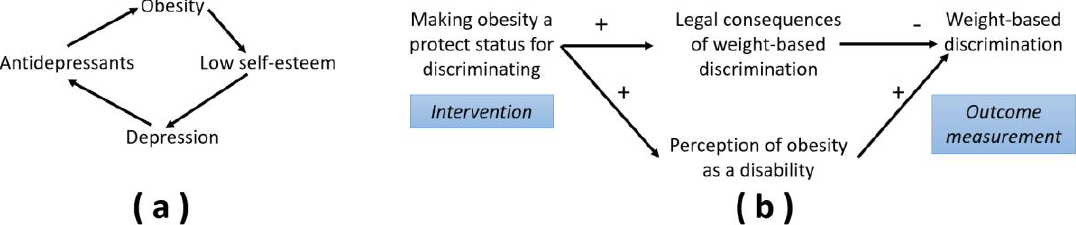
Figure 2. Common tasks in systems thinking with respect to maps include finding structures such as loops ( a ) and disjoint paths ( b ). For policymaking, loops can amplify effects or create inertia, while disjoint paths between an intervention and its measurement can include unintended side effects. The software studied here addresses both structures.